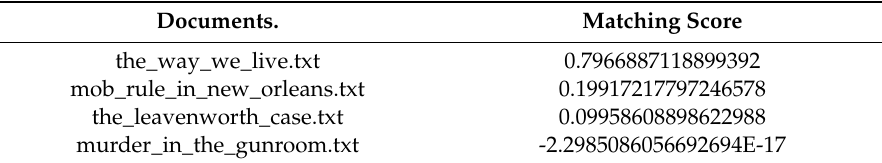
Table A2. Top Docs for TermQuery: prison, kill, and destroy.